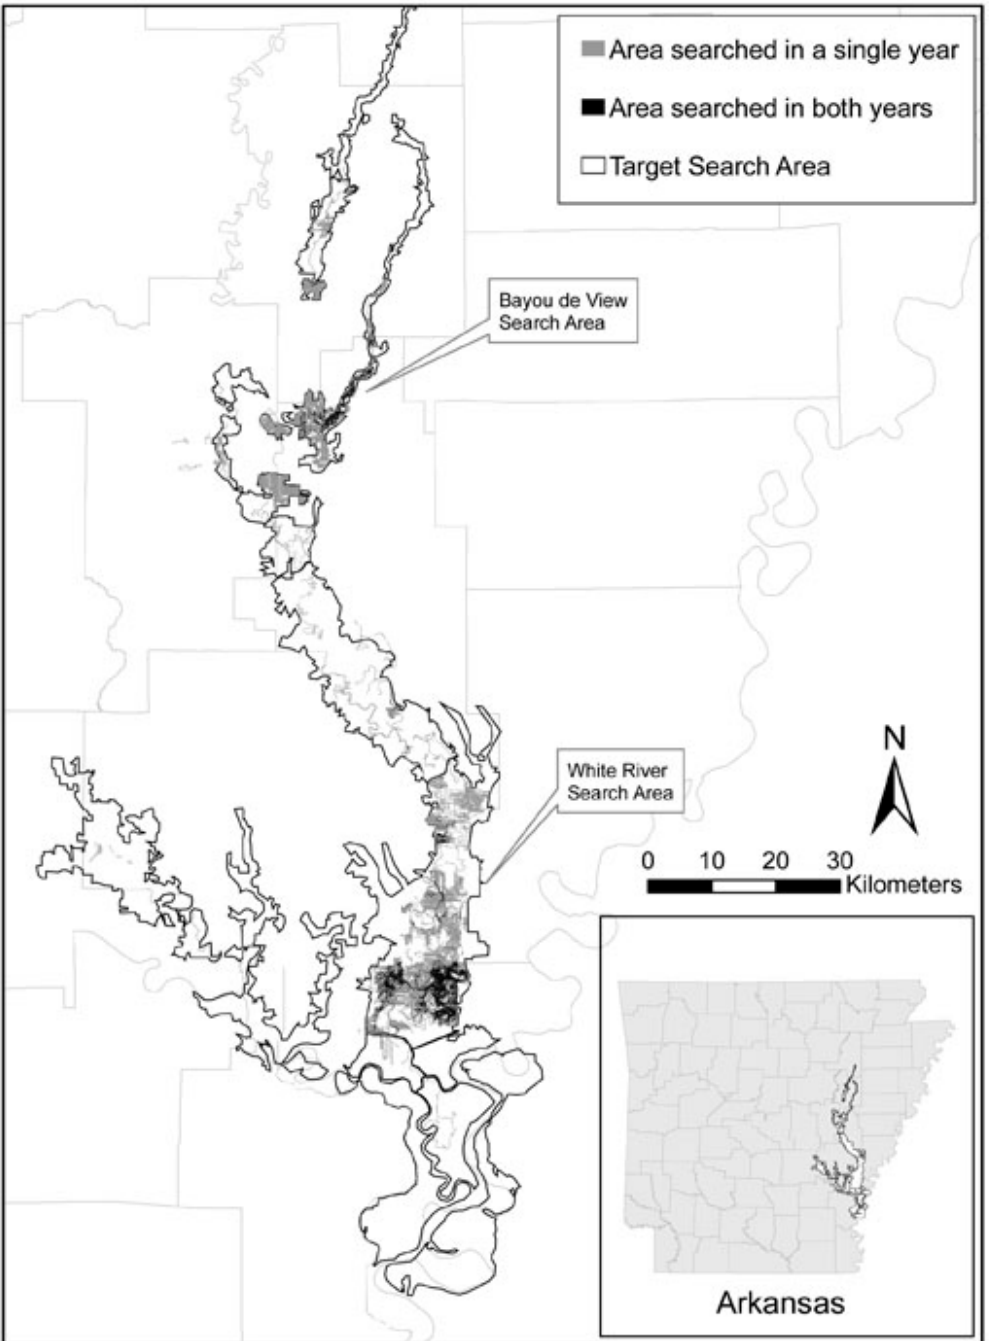
Fig. 1. Map of the target search area for Ivory-billed Woodpeckers in Arkansas, USA, including the extent of search coverage for the Bayou de View and the White River sites in one or both